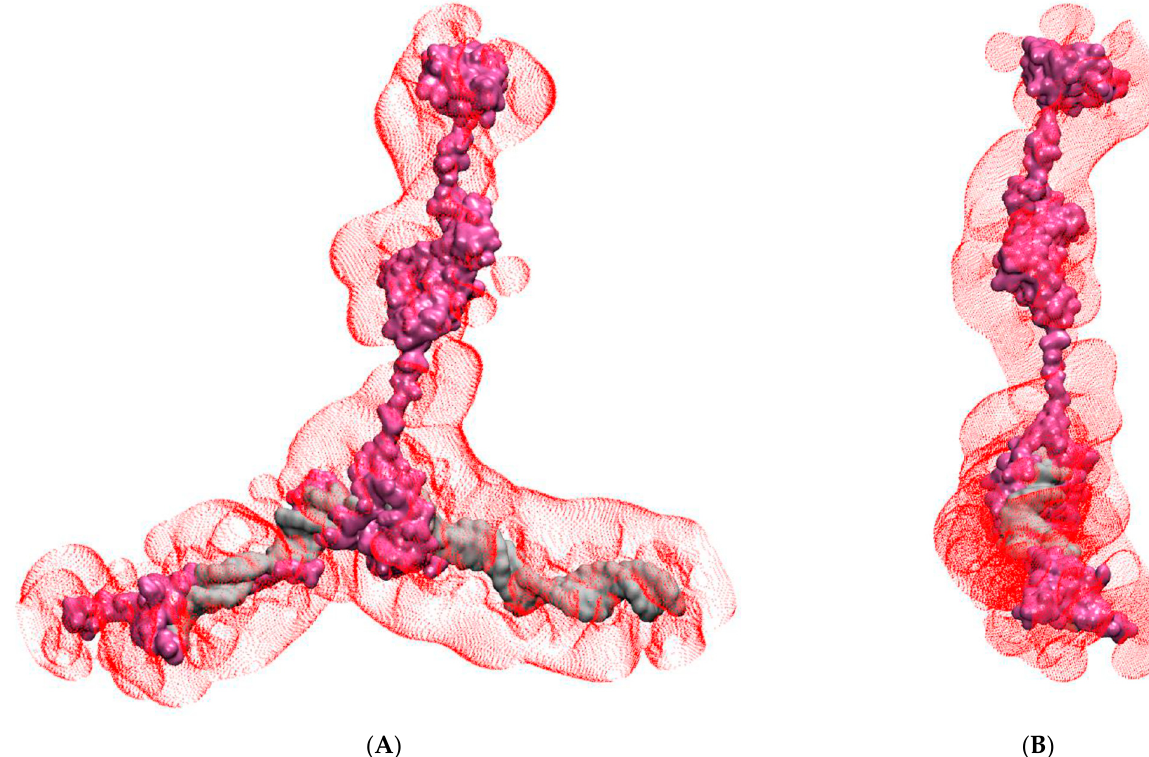
Figure 6. Electrostatic surface of FOXO3 bound to DNA. ( A ) Frontal view of the isoelectric surface representation of the FOXO3-DNA complex. The structure of the FOXO3-DNA complex is shown in surface representation (DNA silver, FOXO3 purple). The red dotted surface represents the isosurface with an isovalue of 0.02. ( B ) Same as in ( A ) but rotated by 90° to allow viewing of the complex along the DNA axis.